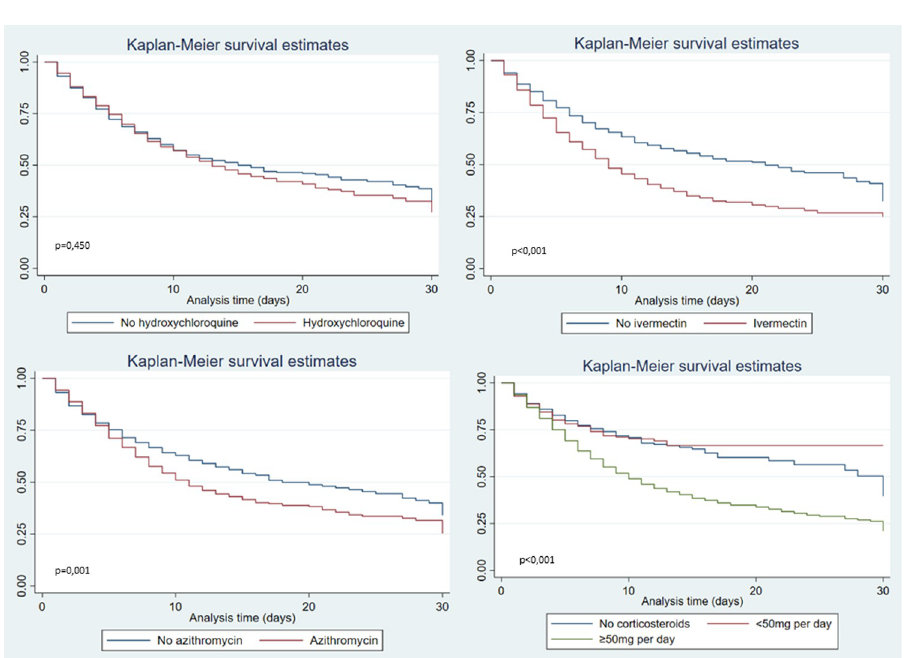
Fig 3. Kaplan-Meier survival curves comparing treatment used in in patients hospitalized with COVID-19 between April and August 2020 in Hospital Nacional Hipolito Unanue. Lima, Peru. P values shown are based on log